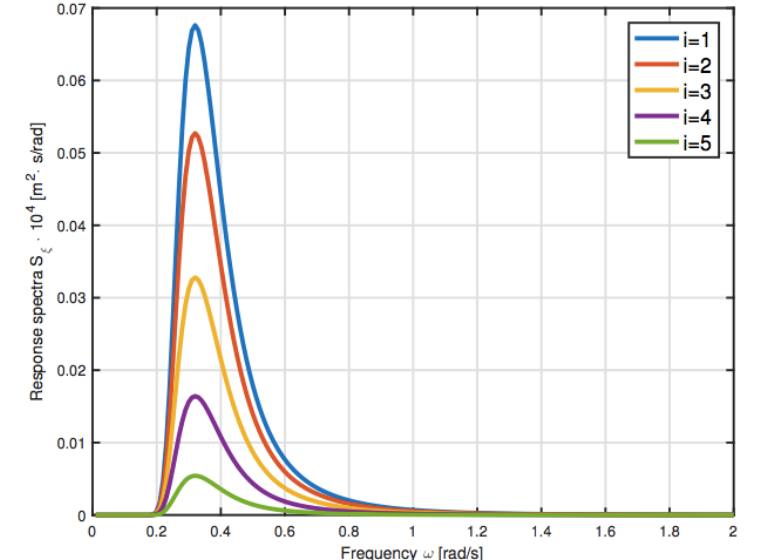
Figure 7. Response spectra for the displacement in physical coordinates of the fixed-leg